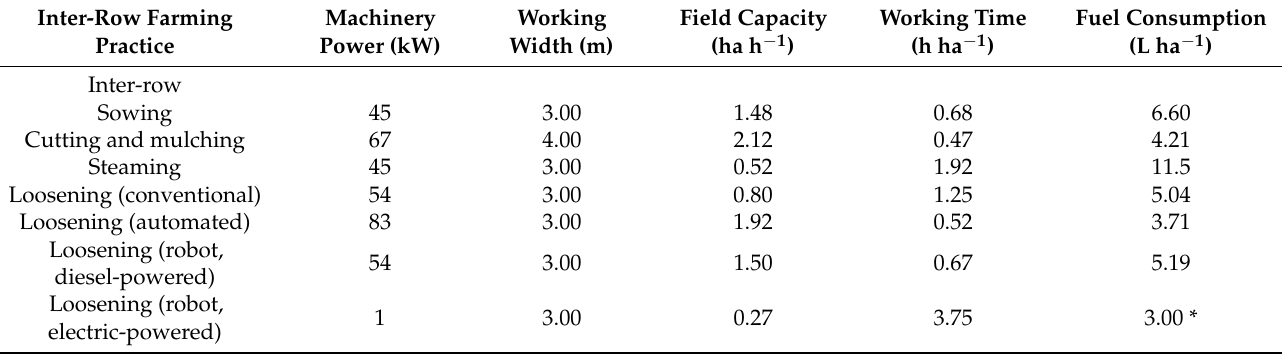
Table 3. Technological indicators of weed control operations (calculated by the authors, according to [51]).